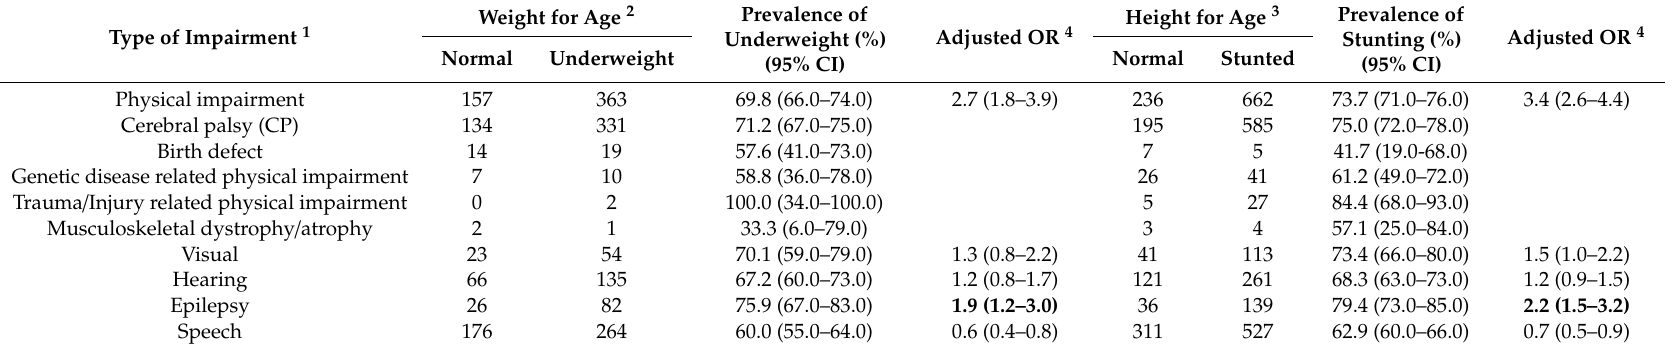
Table 4. Relationship between di ff erent types of impairments and malnutrition among children with